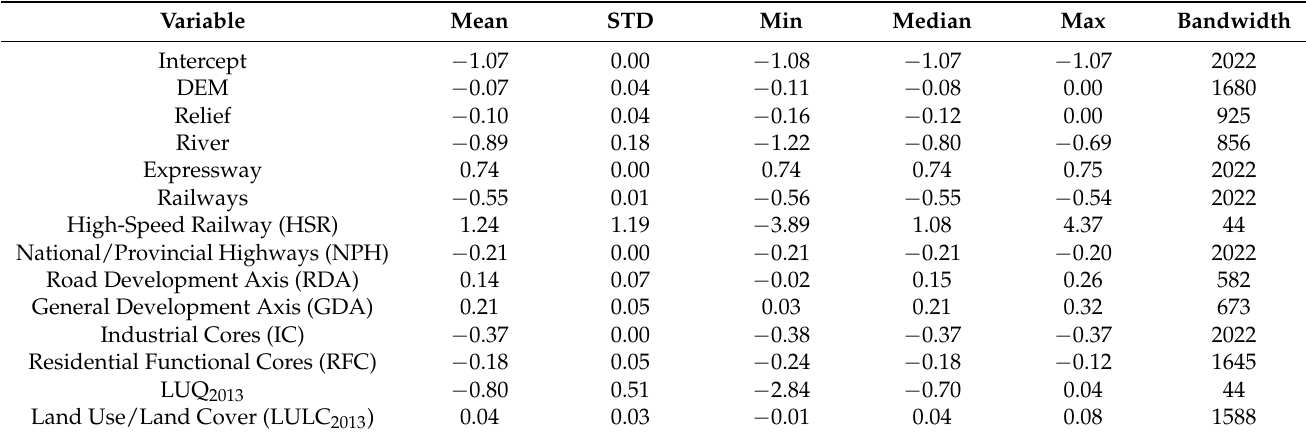
Table 6. MGWR calculated coefficients and scales for each location